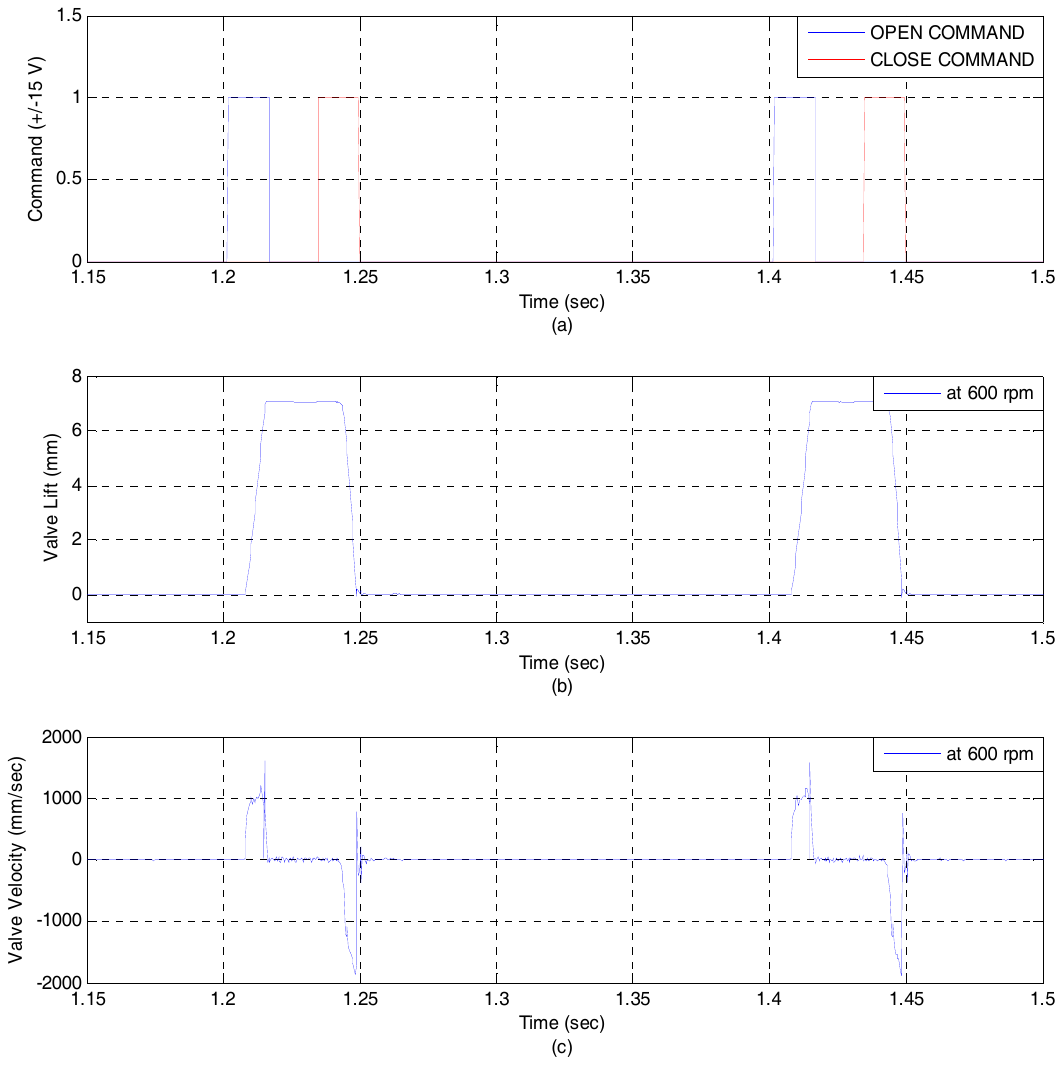
Figure 11. Valve response at 600 rpm and 100 bar (Open loop): ( a ) Open/Close command; ( b ) Valve lift profile; ( c ) Valve velocity profile.